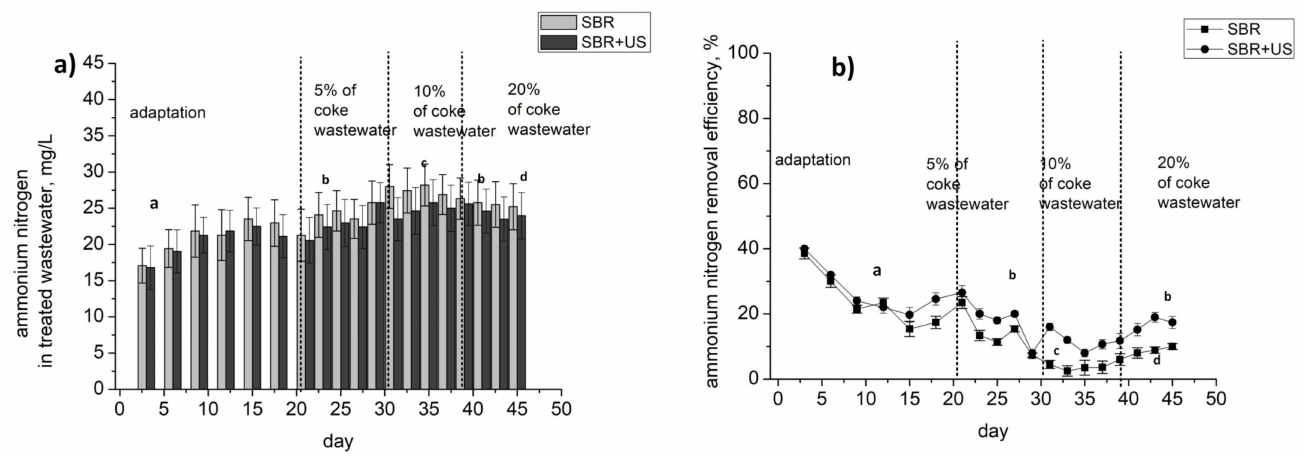
Figure 8. N-NH 4+ changes during treatment in the SBR: ( a ) concentration; ( b ) removal efficiency. (Statistical group a–d).